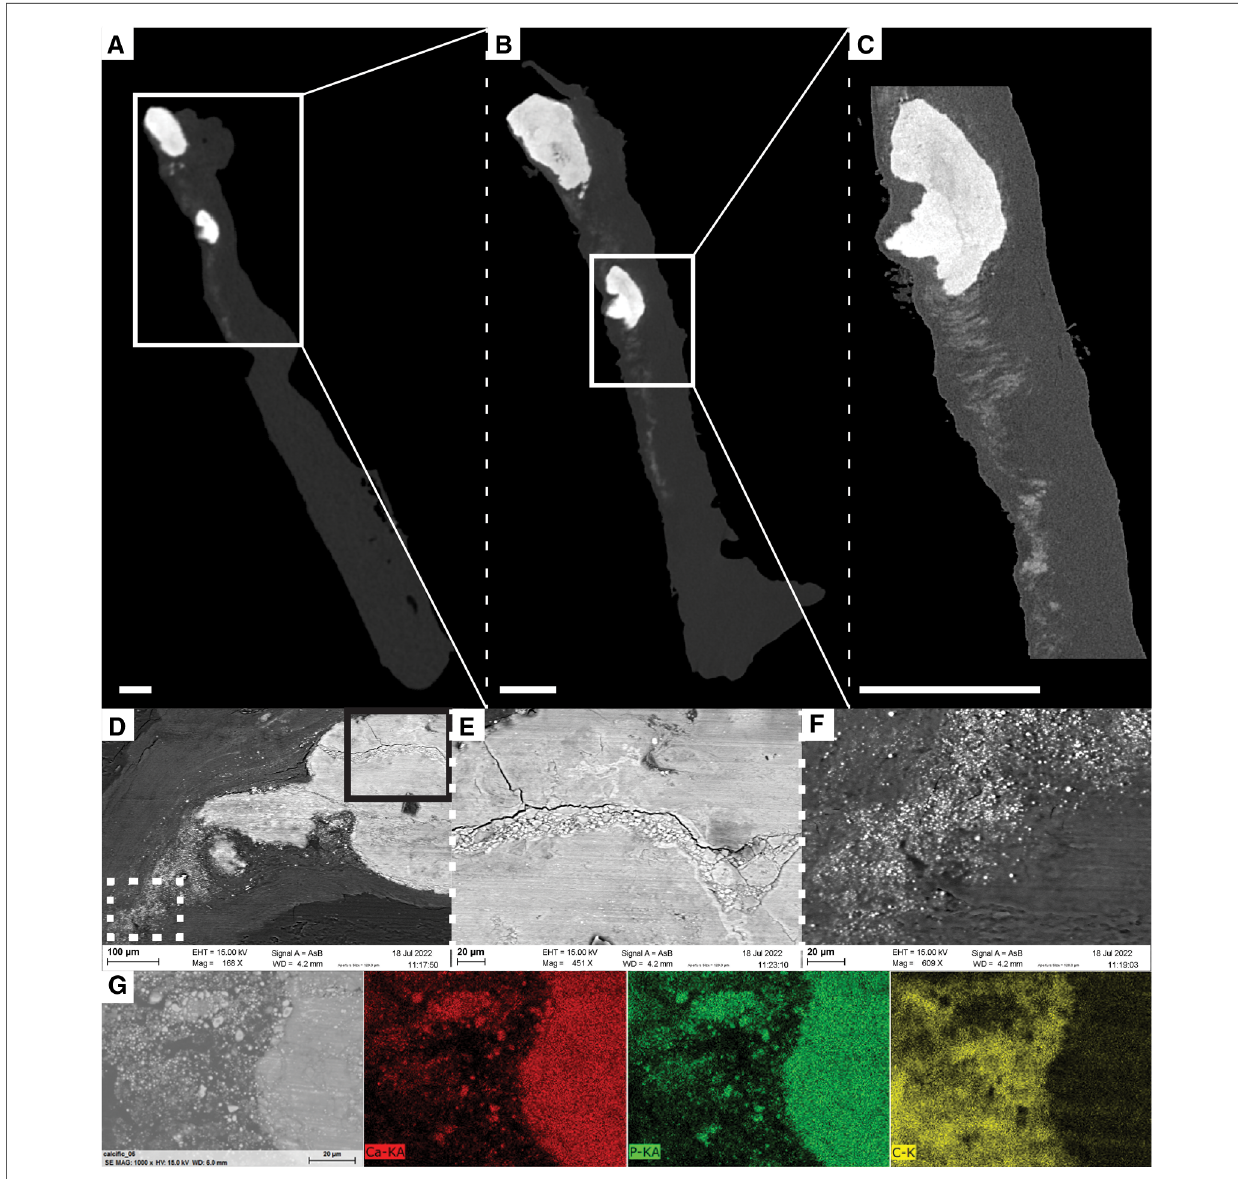
FIGURE 5 Visualization of soft tissue changes next to dense calci fi cations in sample N4.1. ( A – D ) Ortho-slices from ex vivo microCT obtained with different voxel sizes: 14 µm ( A ), 5 µm ( B ) and 1.2 µm ( C ). Scale bars=0.5 mm. White squares correspond to the location of magni fi cation. ( D – F ) SEM images with accumulation of particles within a dense calci fi cation ( E ) and visualization of micro-sized particles in the soft tissue ( F ) obtained with backscattered electron detector, and different magni fi cations: x168 ( D ), x451 ( E ), and x609 ( F ). Solid black square and dotted white square in D correspond to the location of magni fi cations in the dense calci fi cation and in soft tissues, respectively. ( G ) EDX analysis obtained at the border between the soft tissue and the dense calci fi cation demonstrating that dense and micro-sized calci fi cations are composed of Calcium and Phosphate, while soft tissue is composed of